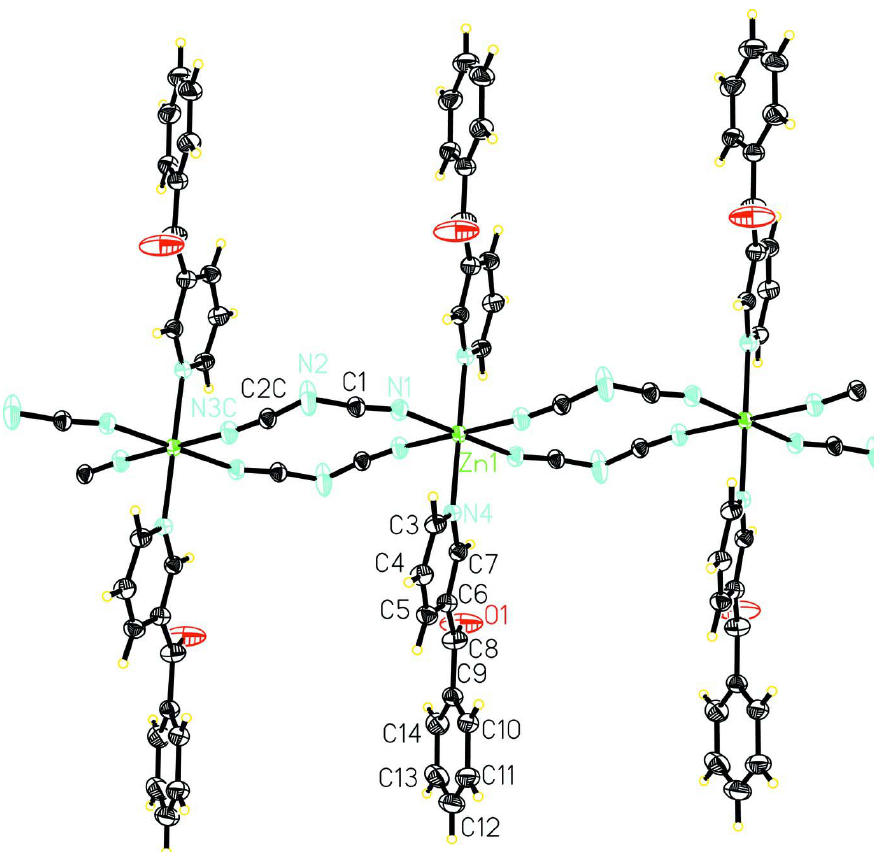
The molecular structure of the title compound with the atom-numbering scheme and all dydrogen atoms. Displacement ellipsoids are drawn at the 30% probability